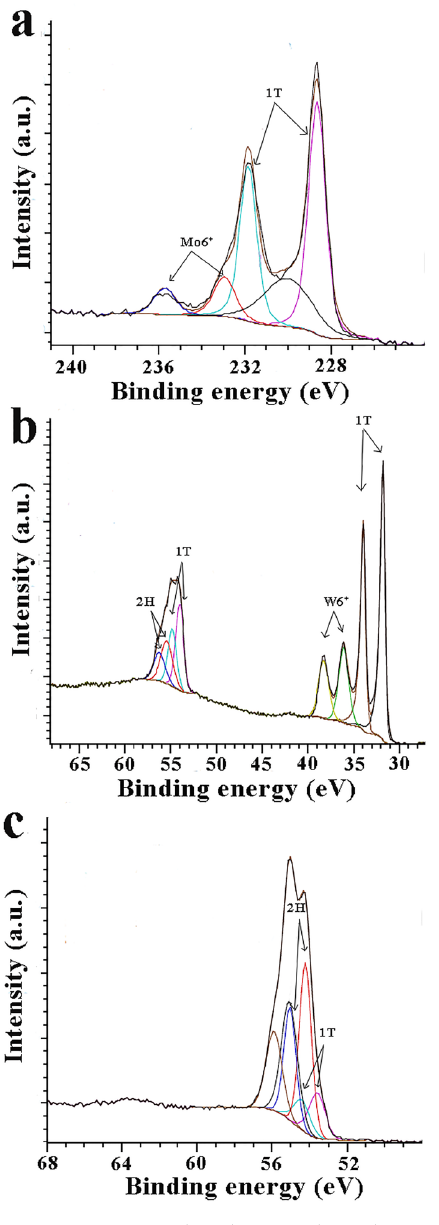
Figure 4. Deconvoluted X-ray photoelectron spectra of ( a ) Mo 3d for MoSe 2 , ( b ) W 4f and Se 3d for WSe 2 , and ( c ) Se 3d for MoSe 2 .